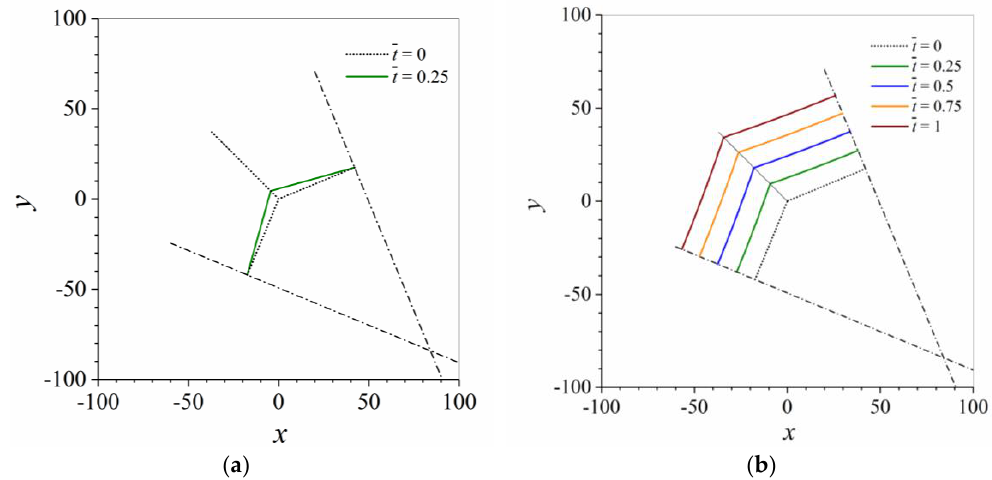
Figure 13. Evolution of the grain boundaries and the triple junction for the symmetry unit of an initially regular heptagon with Λ = 2. ( a ) Case I, ( b ) Case II.